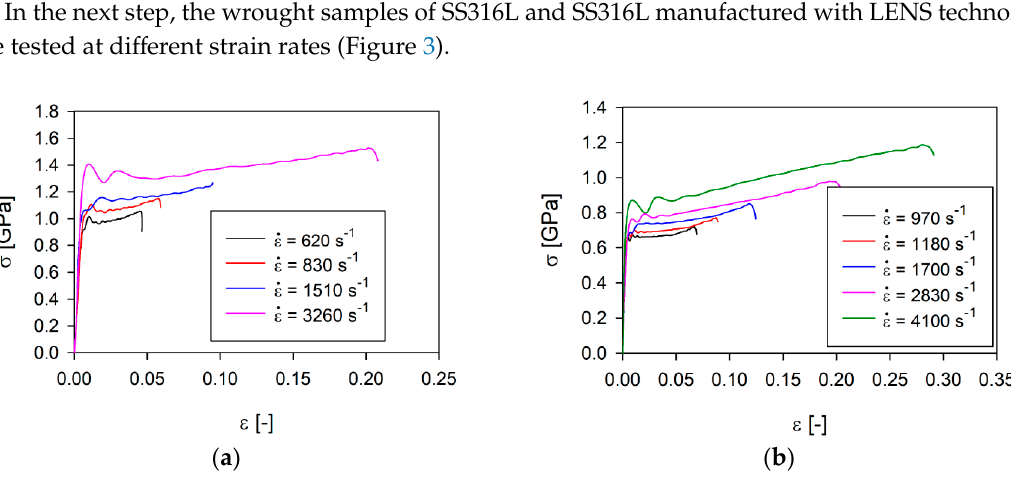
Figure 3. True stress–strain curves of SS316L alloy: ( a ) wrought; ( b ) prepared by LENS technology.